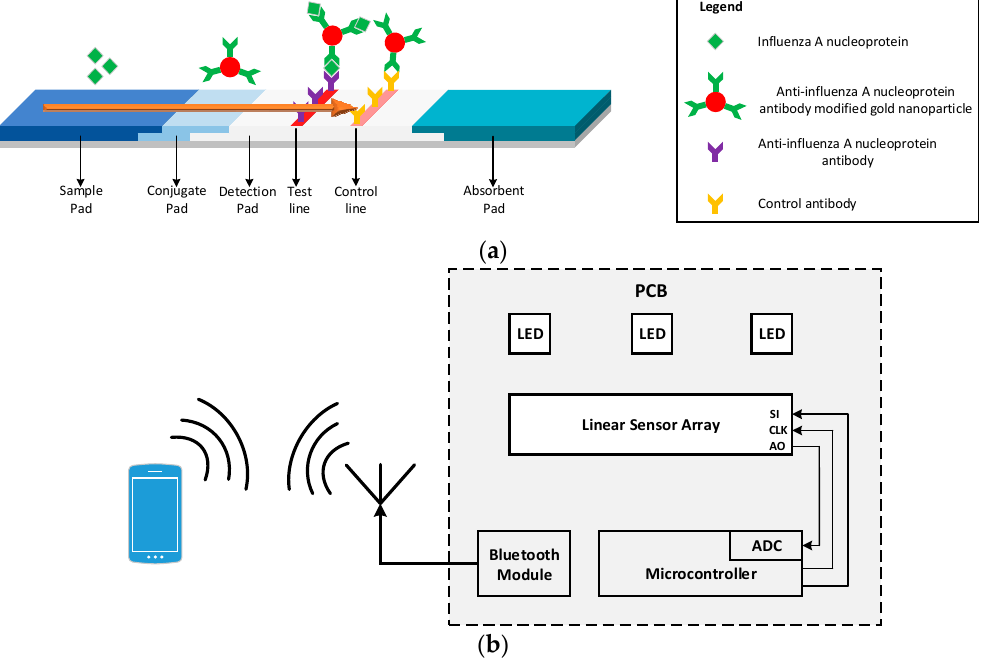
Figure 1. ( a ) Schematic of the LFIA for the detection of Influenza A nucleoprotein; ( b ) Schematic diagram of the reader.